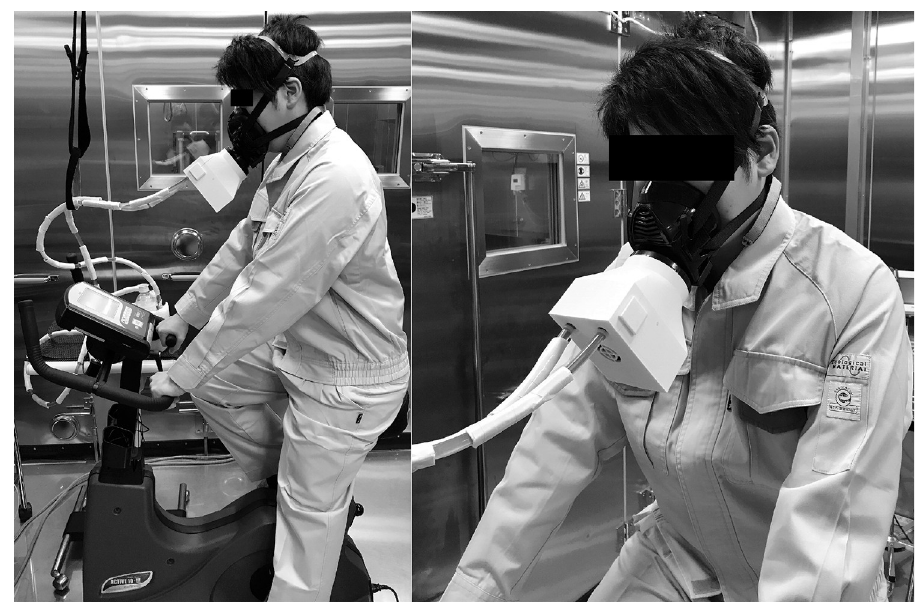
Fig 5. Photograph of the experiment for the measurement of temperature. The subject exercised using the cycle ergometer in a hot artificial climate chamber set at a dry-bulb temperature of 36˚C and relative humidity of 45%. The image shows a subject wearing a powered air-purifying respirator equipped with a cooling